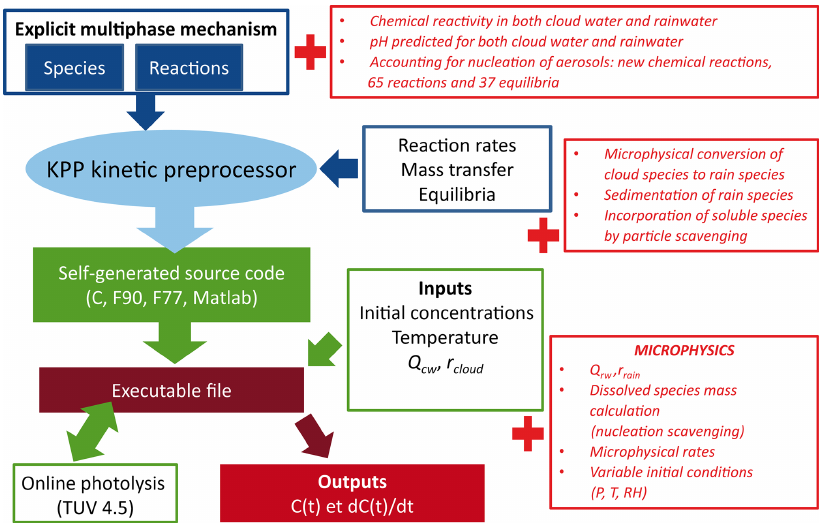
Figure 1. Schematic diagram of CLEPS (Mouchel-Vallon et al., 2017). The developments related to the coupling of CLEPS with the micro- physical scheme are shown in